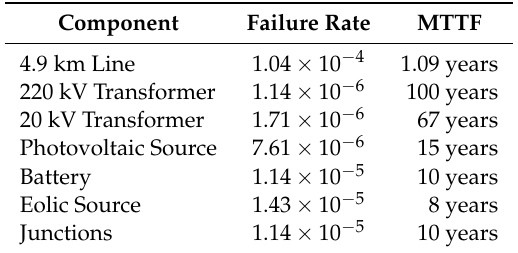
Table 2. Typical failure rates of smart grid components.